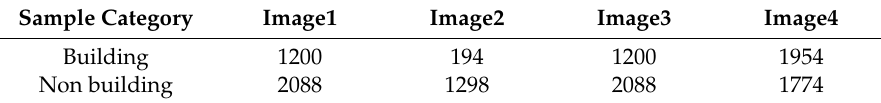
Table 1. Number of sample points marked on the Figure 10 original